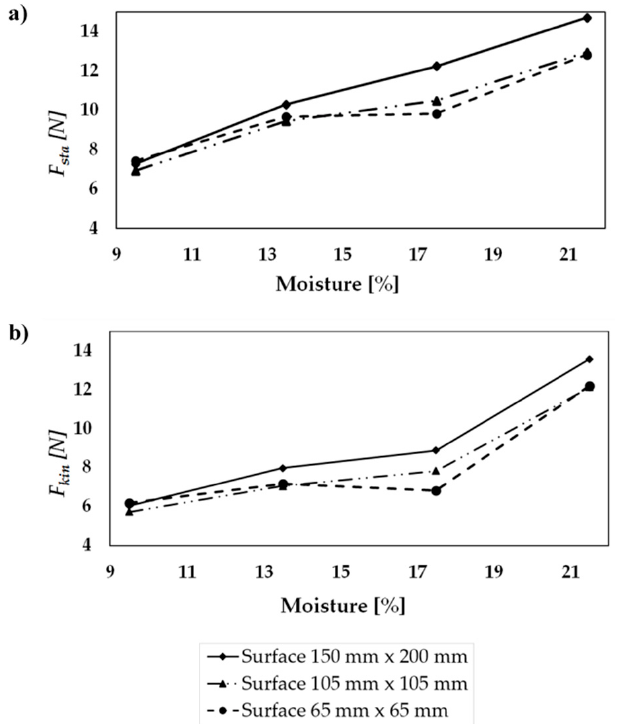
Figure 6. A chart showing the relationship of force of friction to the moisture level of wheat: ( a ) static friction, ( b ) kinetic friction. friction, ( b ) kinetic